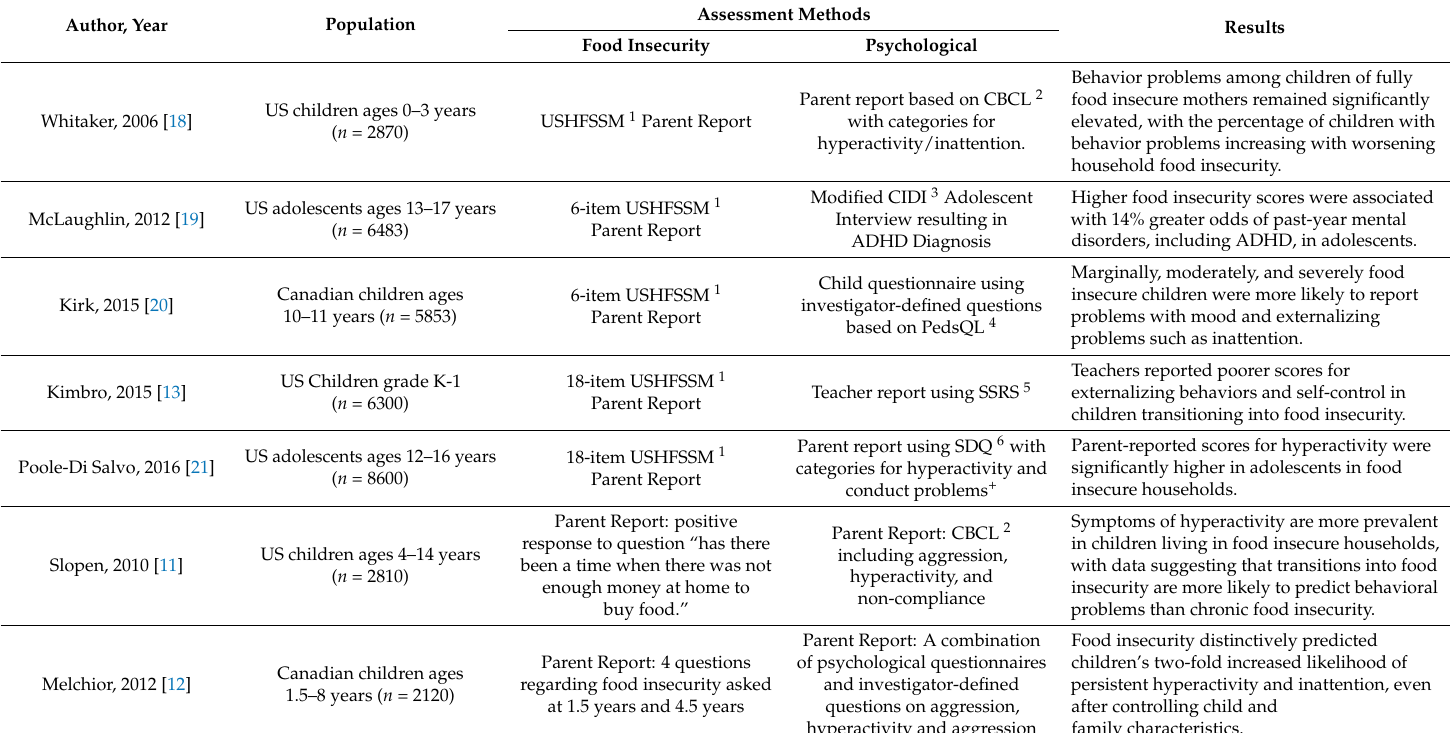
Table 1. Comparison of literature characterizing associations between food insecurity and symptoms of Attention-Deficit Hyperactivity Disorder (ADHD) in a pediatric